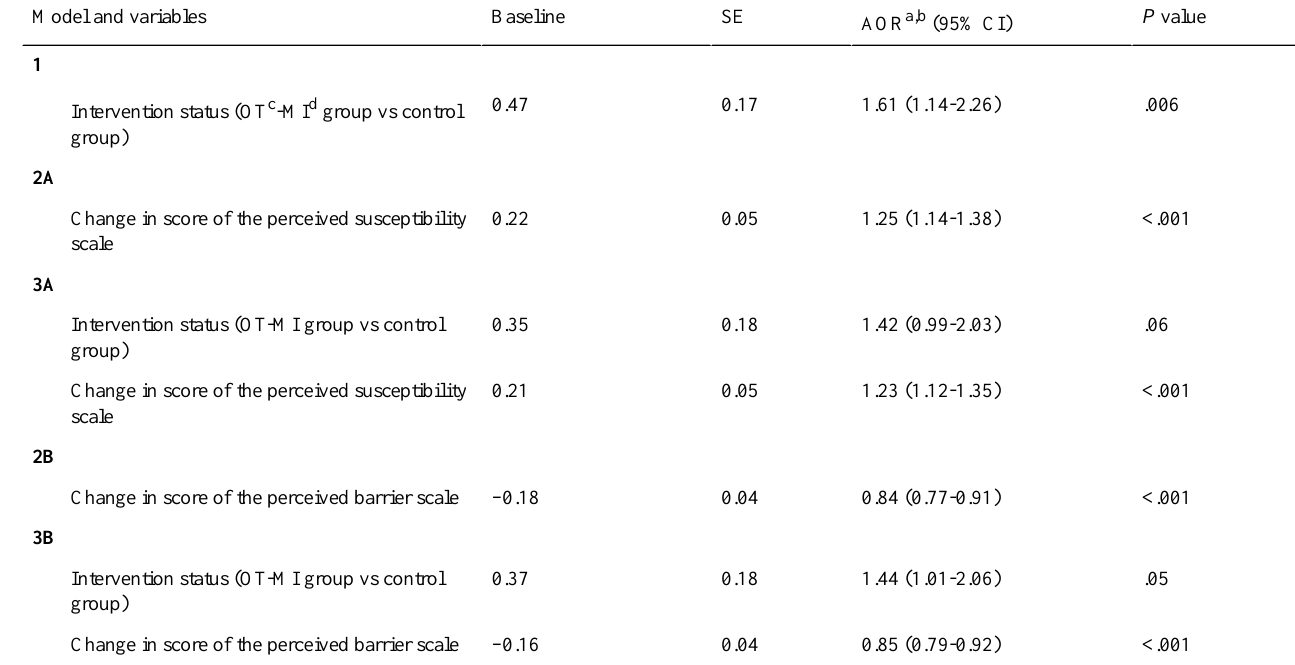
Table 3. Test for the independent effect of changes in Health Belief Model scale scores (24 months vs baseline) on the association between intervention status (online tutorial- motivational interviewing group vs control group) and human papillomavirus vaccination completion during the follow-up period